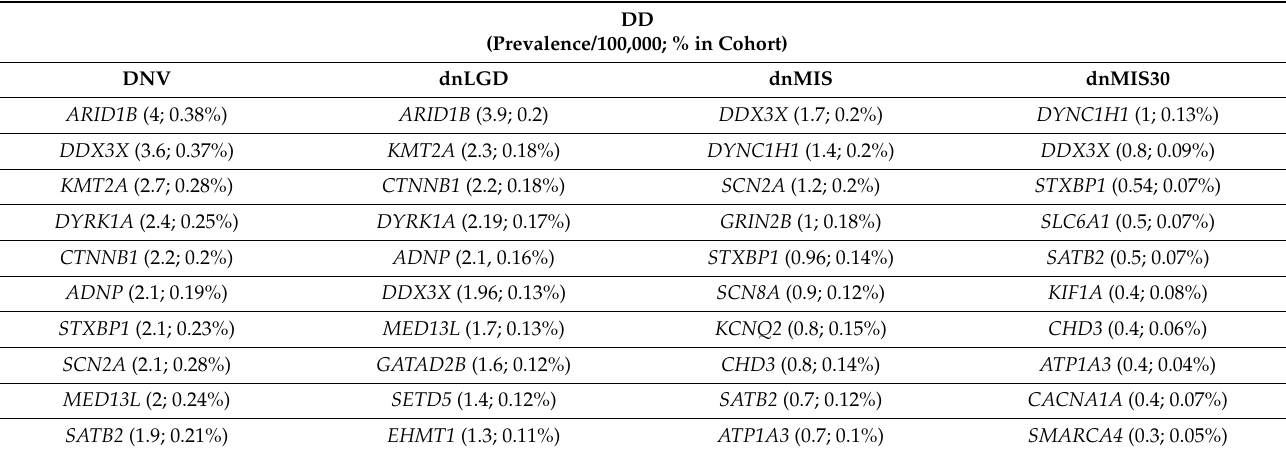
Table 4. Top 10 most prevalent genes with variation among DD.